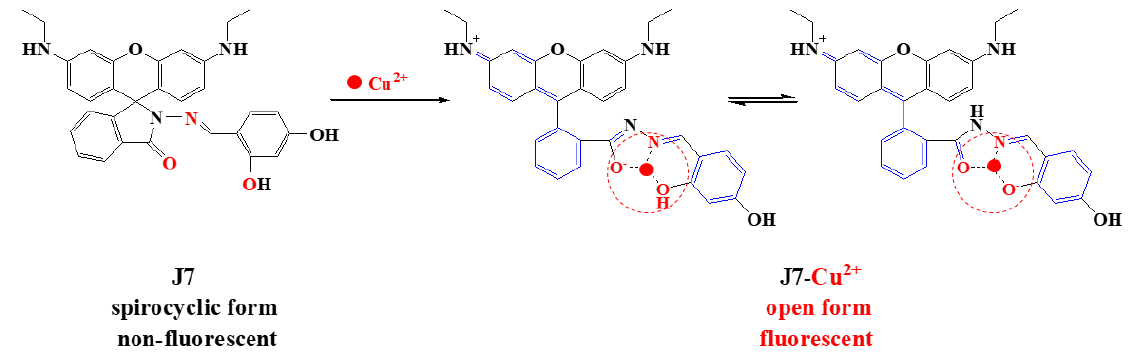
Figure 9. Recognition mechanism of the probe to Cu 2+ (shown as J7). In J6/J7, the two oxygen and one nitrogen atoms located around the spirolactam ring, with higher nucleophilic activity towards Cu 2+ , probably act as the recognition sites to capture target Cu 2+ . When the spirolactam ring opens and thus the three atoms form an appropriate cavity to hold Cu 2+ , then the unbonding electron pairs of the two oxygen and one nitrogen atoms will partly be provided to fulfill the empty electron orbits of Cu 2+ through intramolecular forces [27,28], though weaker than coordination bonds, an obvious electron transfer [29] will then be established and two chelating five- and six- membered rings formed, which contributes to a better planarity and rigid of the J6/J7-Cu 2+ system. And stronger fluorescence intensity of the J6/J7-Cu 2+ system accompanied with the extended conjugated chain (the extended conjugation chain was labelled in blue in Figure 9) and better molecular